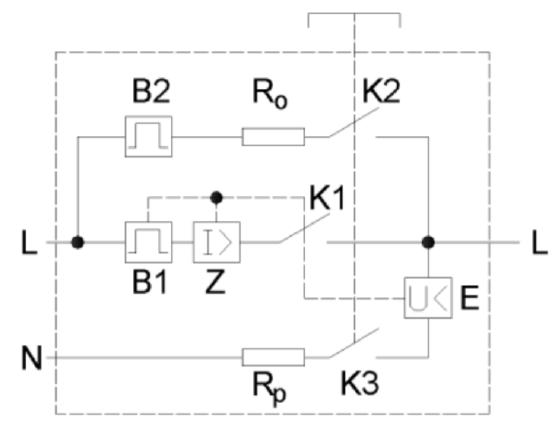
Figure 2. An example of the SCB electrical scheme.